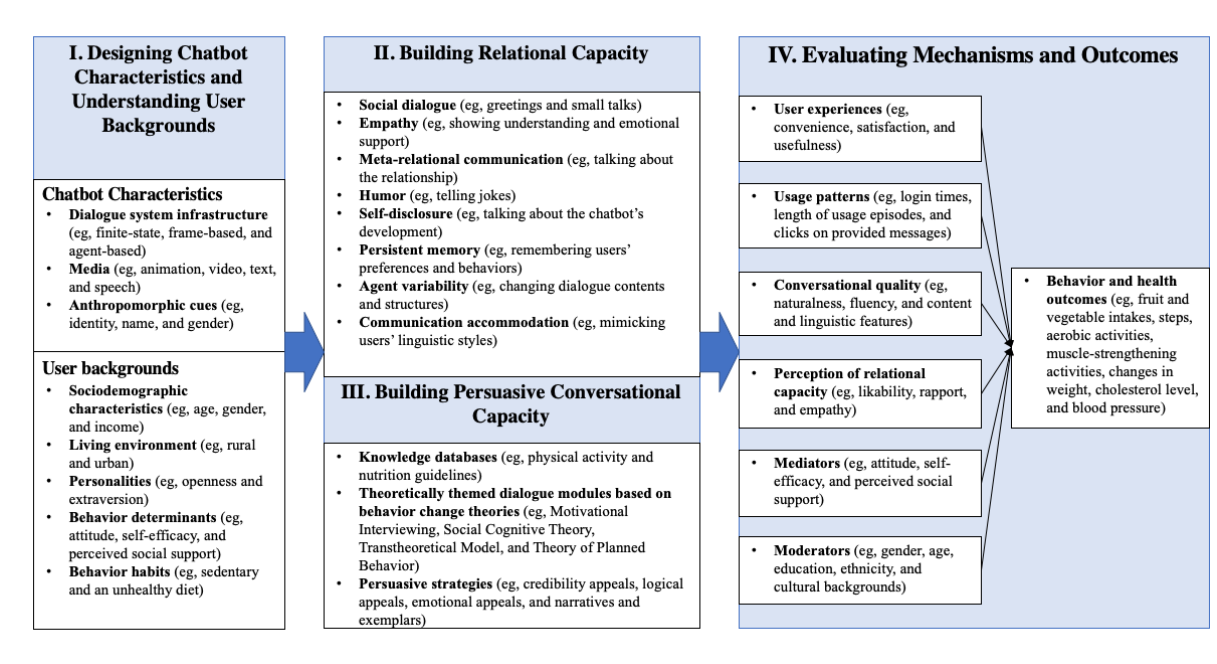
Figure 1. The artificial intelligence chatbot behavior change